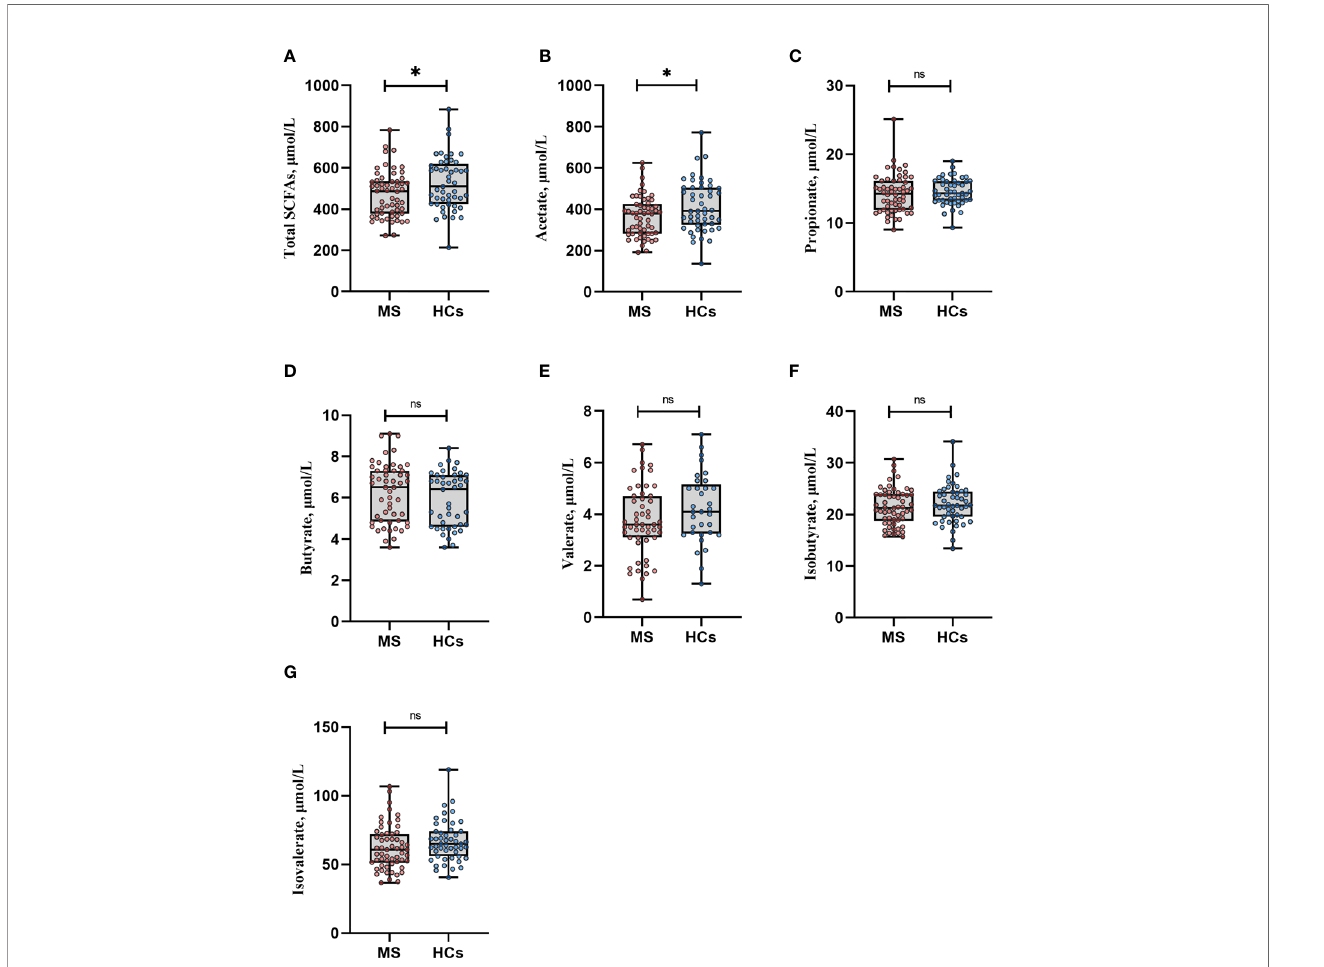
FIGURE 1 | Serum SCFA levels in multiple sclerosis (MS) patients and healthy controls (HCs). (A, B) Total amount of short-chain fatty acids ( SCFAs) and acetate levels were lower in MS patients compared with HCs. (C – G) Propionate, butyrate, valerate, isobutyrate and isovalerate did not differ signi fi cantly between MS and HCs, by Mann Whitney U test. *p<0.05. Boxplots display median, inter quartile range, minimum and maximum. Each dot represents an individual value. Similar results were obtained when adjusting for sex, age, BMI, smoking status, probiotics and dietary pattern in an ANCOVA test. However, after adjustment for multiple testing all q values became non-signi fi cant, q>0.05. SCFAs: short-chain fatty acids, ns., non-signi fi